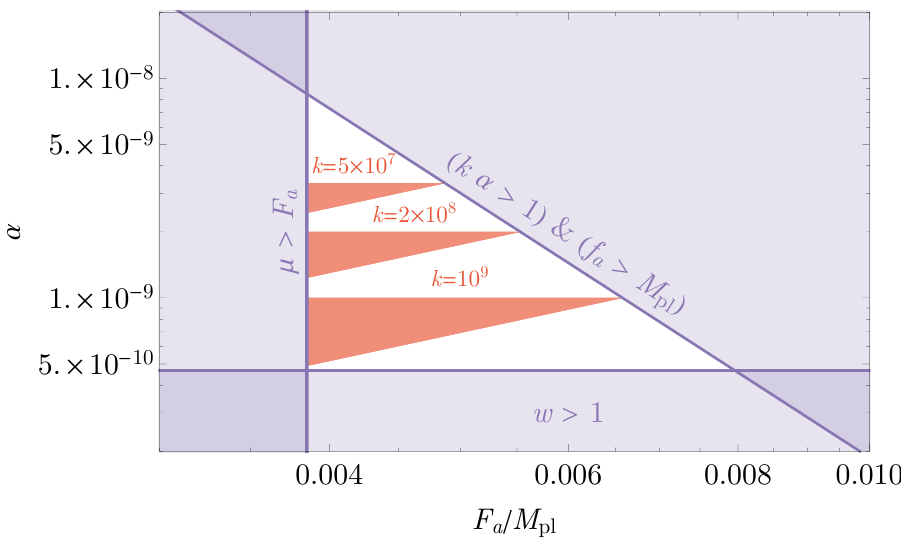
Figure 1 . Viable parameter space for chromonatural in(cid:13)ation. We assume the number of e-folds of in(cid:13)ation, N e = 60, and (cid:1) 2 = 2 : 2 (cid:2) 10 (cid:0) 9 as well as other theoretically motivated constraints R discussed in the text. The red regions show the allowed parameter space for particular values of k